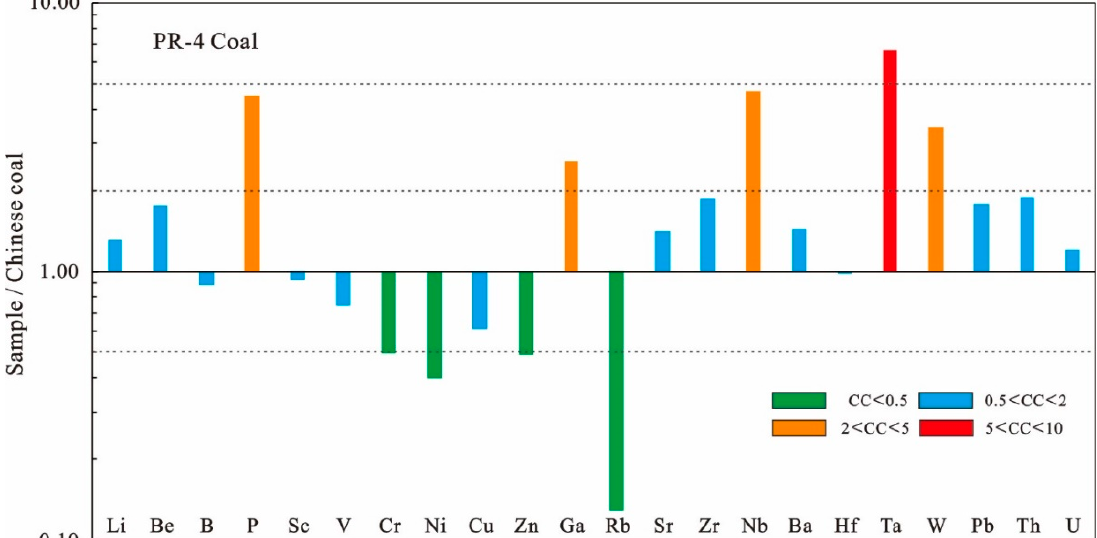
Figure 11. Concentration coefficients (CC) of trace elements of the No. 4 coals in the Permian of the Puran coal mine. Normalized by averages of trace elements in the Chinese coals [3].